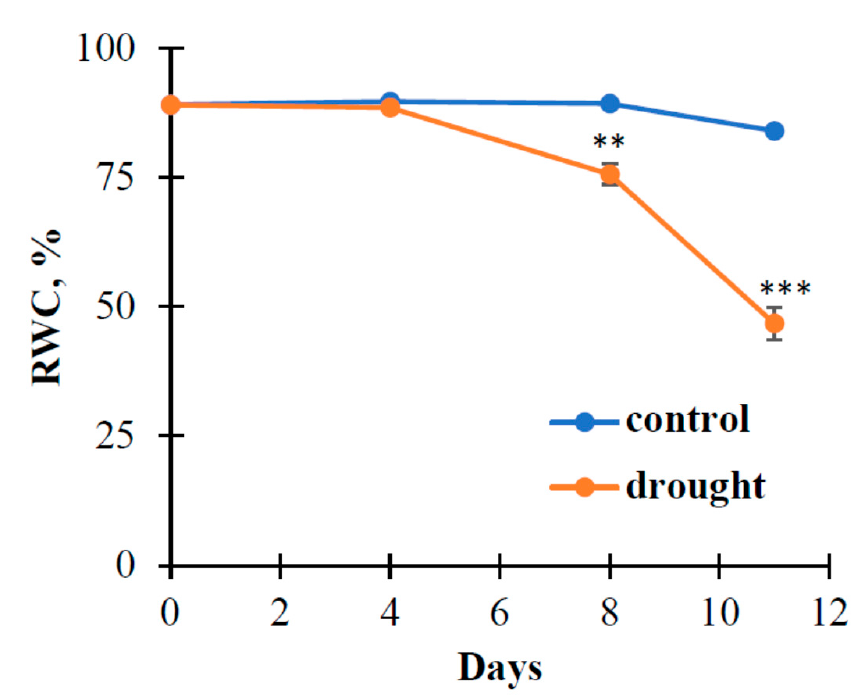
Figure 7. The influence of soil drought on relative water content (RWC) in wheat plants under open-ground conditions. * p < 0.05; ** p < 0.01; *** p < 0.001.